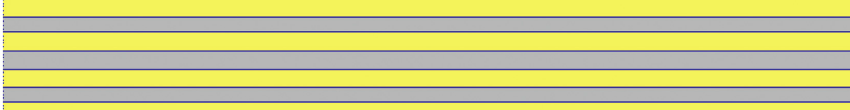
Figure 14: Interference layer with a thickness of 35 m.